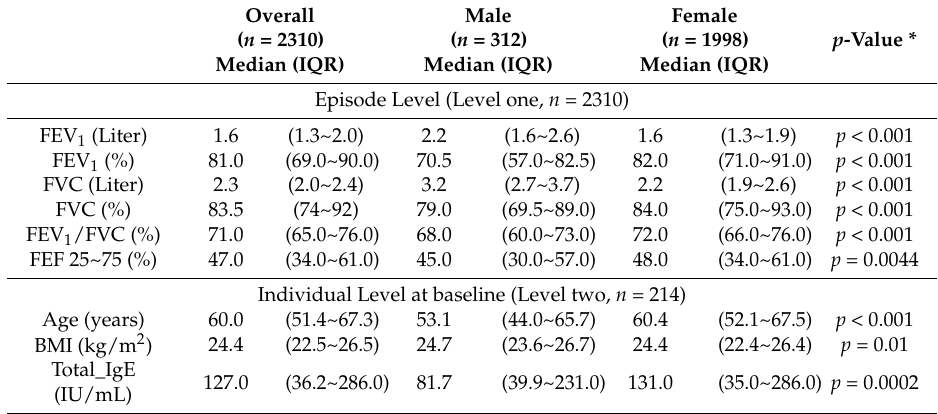
Table 1. Distributions of age, lung function, or total immunoglobulin E (IgE) level according to sex in neversmoking